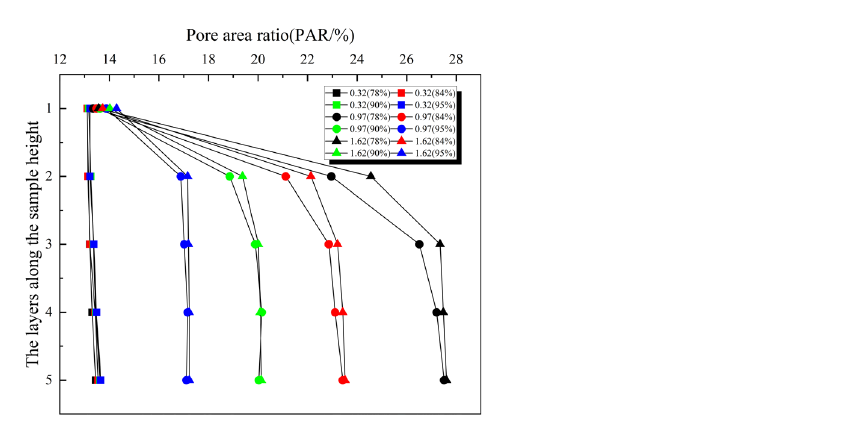
Figure 8. Variation of PAR with different H/D ratios along the sample height after compression. The distribution of pores is a direct reflection of variation in soil structure. The pores in loess can be classified into four types based on their mean radius [32]: micropores (<1 μm), small pores (1–4 μm), mesopores (4–32 μm), and macropores (>32 μm). Figure 9 il- lustrates the distribution of pores in different layers with the H/D ratio of 0.32 and 1.62 at a compaction degree of 78%. The distribution of the same type of pores varied little across all layers before compression, with the largest differences in the area of macropores, mes- opores, small pores, and micropores of 1.38%, 4.36%, 5.42%, and 11.81%, respectively, and the largest differences in pore numbers of 11.11%, 10.61%, 10.11%, and 19.31%, respec- tively. This suggests that the remolded loess sample was uniform, and the influence of sample inhomogeneity on test results can be ignored. After compression, the changes in pores at different H/D ratios showed obvious differences. For an H/D ratio of 0.32, the area of macropores and mesopores in different layers decreased by approximately 96% and 74%, while the decrease was approximately 95% and 55% for their number. Mean- while, the area of micropores and small pores in different layers increased by about 200% and 300%, while the increase was about 200% and 330% for their number. At an H/D ratio of 1.62, the first layer showed the most noticeable pore alteration, which was the same as the H/D ratio of 0.32. The area and number of pores in the fifth layer were almost un- changed from before compression. The results showed that, as the H/D ratio increased, the compression of remolded loess was mainly dominated by macropores and mesopores, while small pores and micropores contributed little to the compression. This can be as- cribed to the significant instability of the structure of the macropores and mesopores, which makes them more vulnerable to pressure destruction [33,34]. ( a ) Pore area (H/D = 0.32)